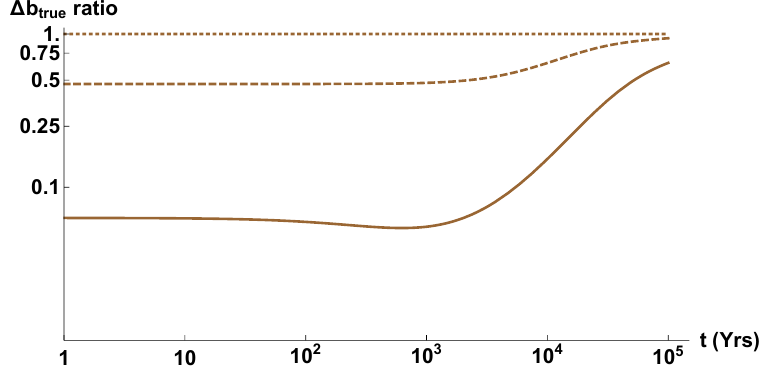
(cid:8)(cid:8) SPP Figure 5 . The ratio (cid:1) b = (cid:1) b SPP for m (cid:31) = 10 (cid:0) 2 eV and (cid:15) = 10 (cid:0) 11 (solid), 10 (cid:0) 12 (dashed) and true true 10 (cid:0) 13 (dotted). The ratios may deviate signi(cid:12)cantly from unity and have appreciable evolution. to that with ((cid:1) b SPP ) mCP SPP, is shown in (cid:12)gure 5. The curves are for parametric values true (cid:15) = f 10 (cid:0) 11 ; 10 (cid:0) 12 ; 10 (cid:0) 13 g and m = 10 (cid:0) 2 eV. For these values, F (cid:31) (cid:8)(cid:8) values, the ratio (cid:1) b = (cid:1) b SPP di(cid:11)ers signi(cid:12)cantly from unity and also shows appreciable SPP true true time